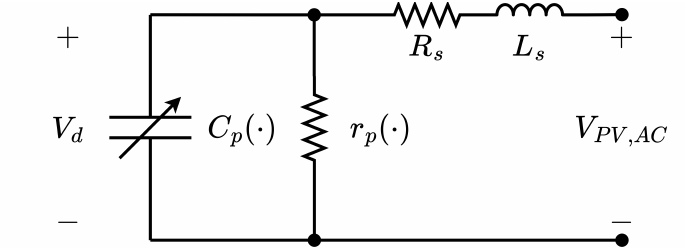
Figure 3. Circuit schematic of the small-signal AC sub-model. Developed from [21].